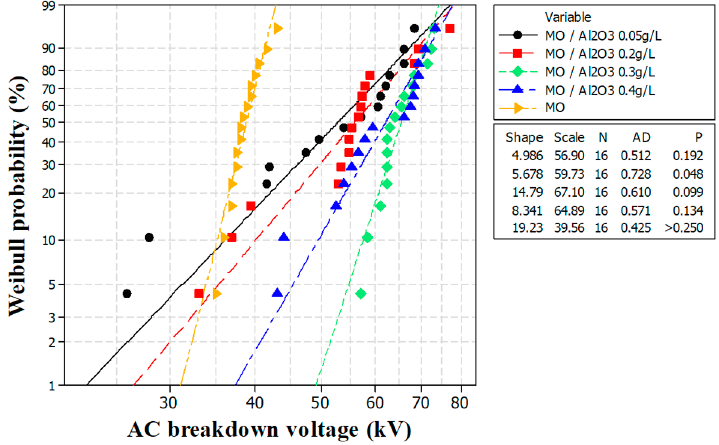
Figure 6. Weibull probability of the average reading of the breakdown voltage of MO/Al 2 O 3 (50 nm) NFs. Table 3. AC breakdown voltage at different breakdown probabilities of various nanofluids. BDV